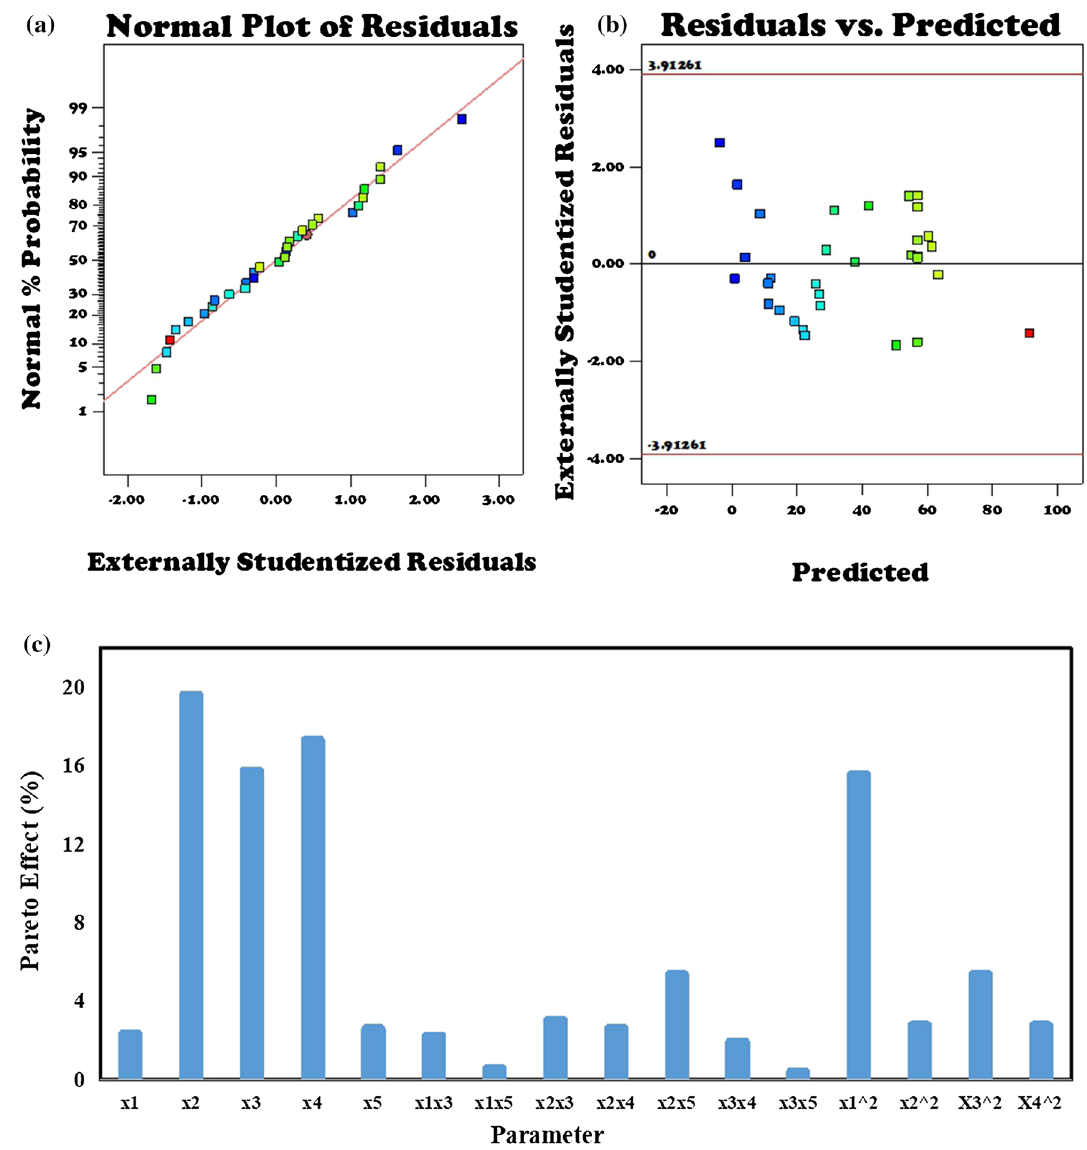
Fig. 4 RSM plots for a Normal residuals, b residual vs. predicted, and c Pareto